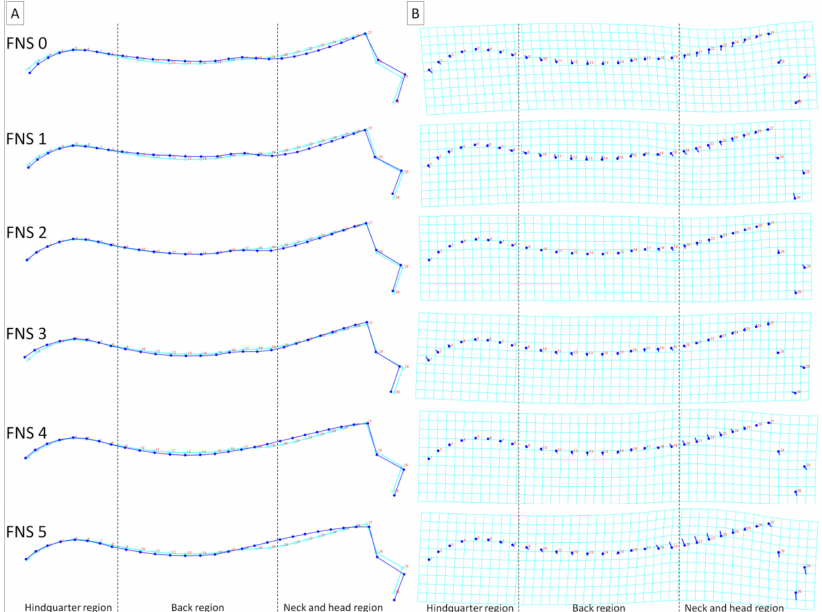
Figure 6. Average observations of the donkeys’ dorsal profiles grouped by body condition score (BCS 2, BCS 3, and BCS 4) and represented by ( A ) wireframe graphs and ( B ) a transformation grid. In the wireframe graphs, light blue landmarks and curves represent the consensus donkey’s dorsal profile and the dark blue landmarks and curves represent the average observations for the subsequent BCS scores. On the transformation grid, dark blue landmarks represent the consensus donkey’s dorsal profile as well as dark blue lines represent the average observations for subsequent BCS scores. Dashed lines indicate the boundaries between regions. Consecutive landmarks are marked with increasing numbers from the first caudalis vertebra (1) to the tuber faciale (30).